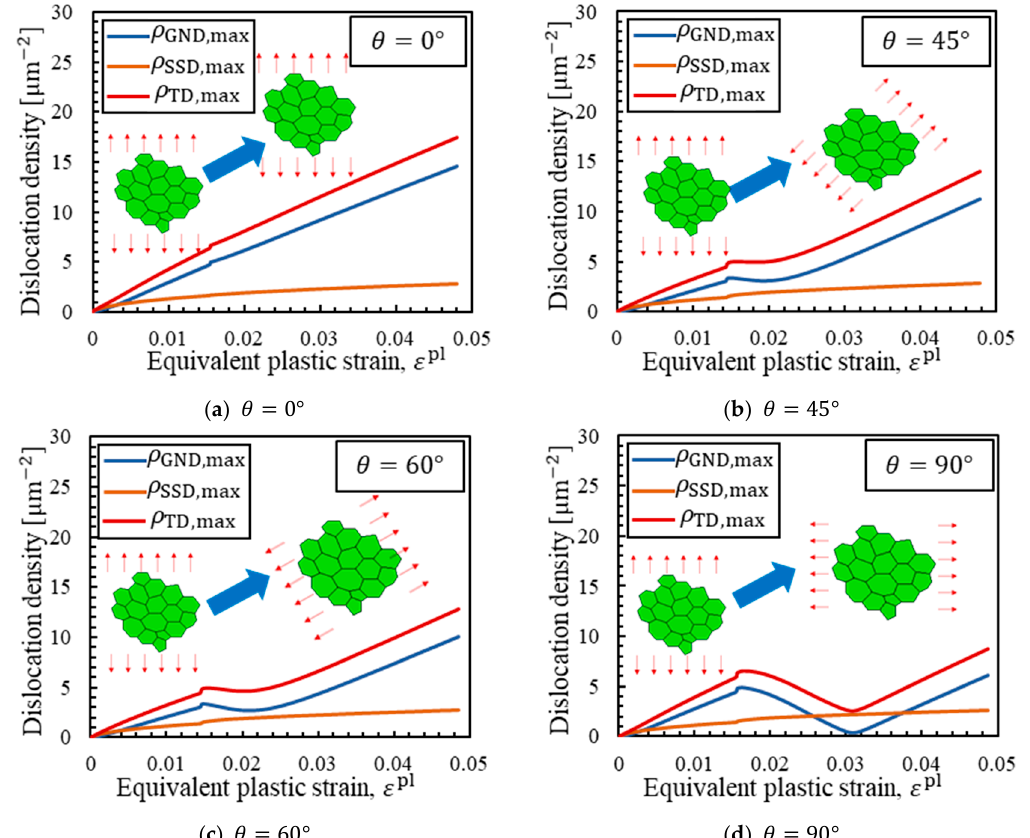
Figure 8. Change in peak dislocation density for each prestrain condition. ( a ) 𝜃 = 0° , ( b ) 𝜃 = 45° , ( c ) 𝜃 = 60° , ( d ) 𝜃 = 90° .